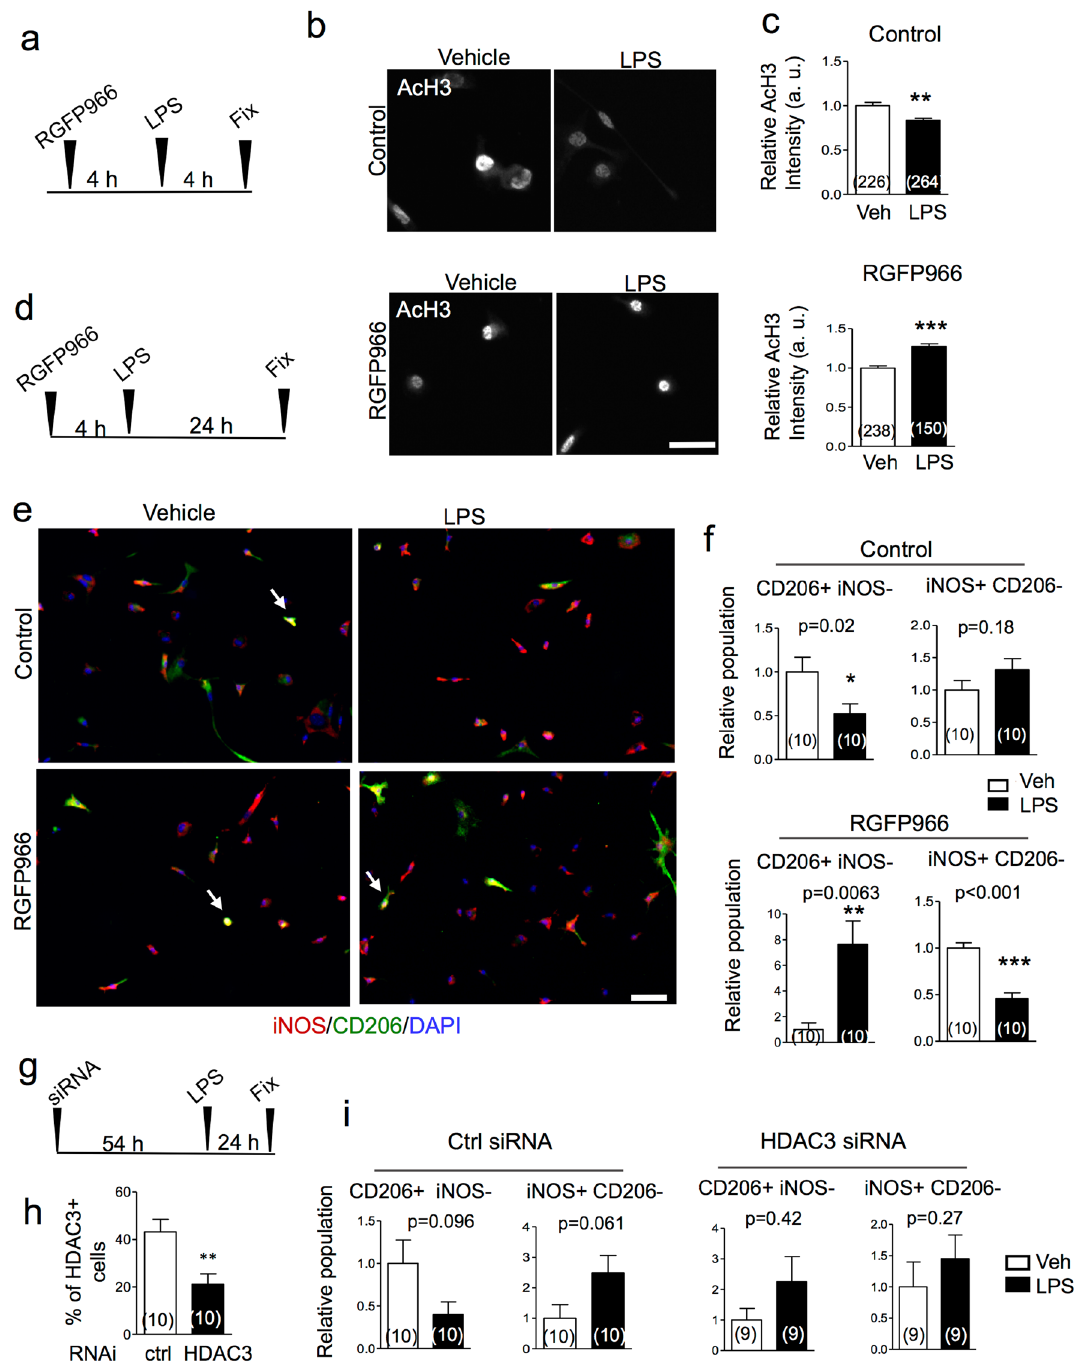
Figure 6. HDAC3 activity contributes to inflammatory activation of microglia. ( a – c ) Experimental scheme, representative images of immunocytochemistry, and quantification show that LPS stimulation results in reduced AcH3 levels in primary microglia by 4 hr. Pre-exposure to RGFP966 reverses LPS-triggered AcH3 reduction. The numbers inside the bar graph indicate the numbers of cells quantified from nine photographs for each experimental condition. Mann Whitney test. ** p = 0.0079, *** p < 0.001. ( d – f ) Experimental scheme, representative images of immunocytochemistry and quantification show that LPS stimulation decreases CD206 + population (green) and a trend of increase in iNOS + population (red). RGFP966 pre-treatment reversed the LPS-induced bias, leading to increased CD206 + population and deceased iNOS + population. DAPI for nuclear counterstaining. Arrow: examples of double positive (iNOS + CD206 + ) cells. The numbers inside the bar graph indicate the numbers of images quantified. Mann Whitey test and unpaired Student’s t test, respectively. ( g – i ) Experimental scheme and quantification show HDAC3 knockdown by siRNA in primary microglia (unpaired Student’s t test). HDAC3 knockdown abolishes the polarized responses of microglia to LPS stimulation. The numbers inside the bar graph indicate the numbers of images quantified by Mann Whitney tests. Scale bar: 25 µ m ( a ) and 50 µ m ( e